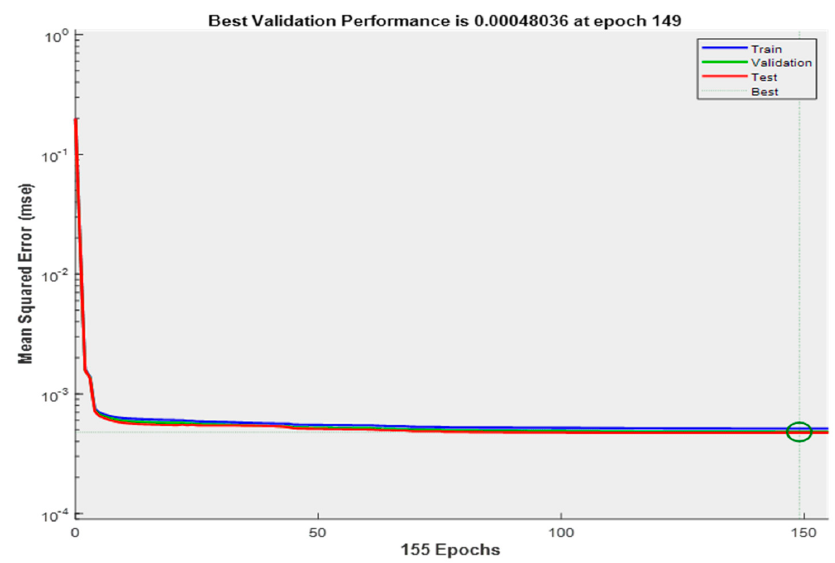
Figure 4. Training performance showing mean squared error (mse) with epochs.